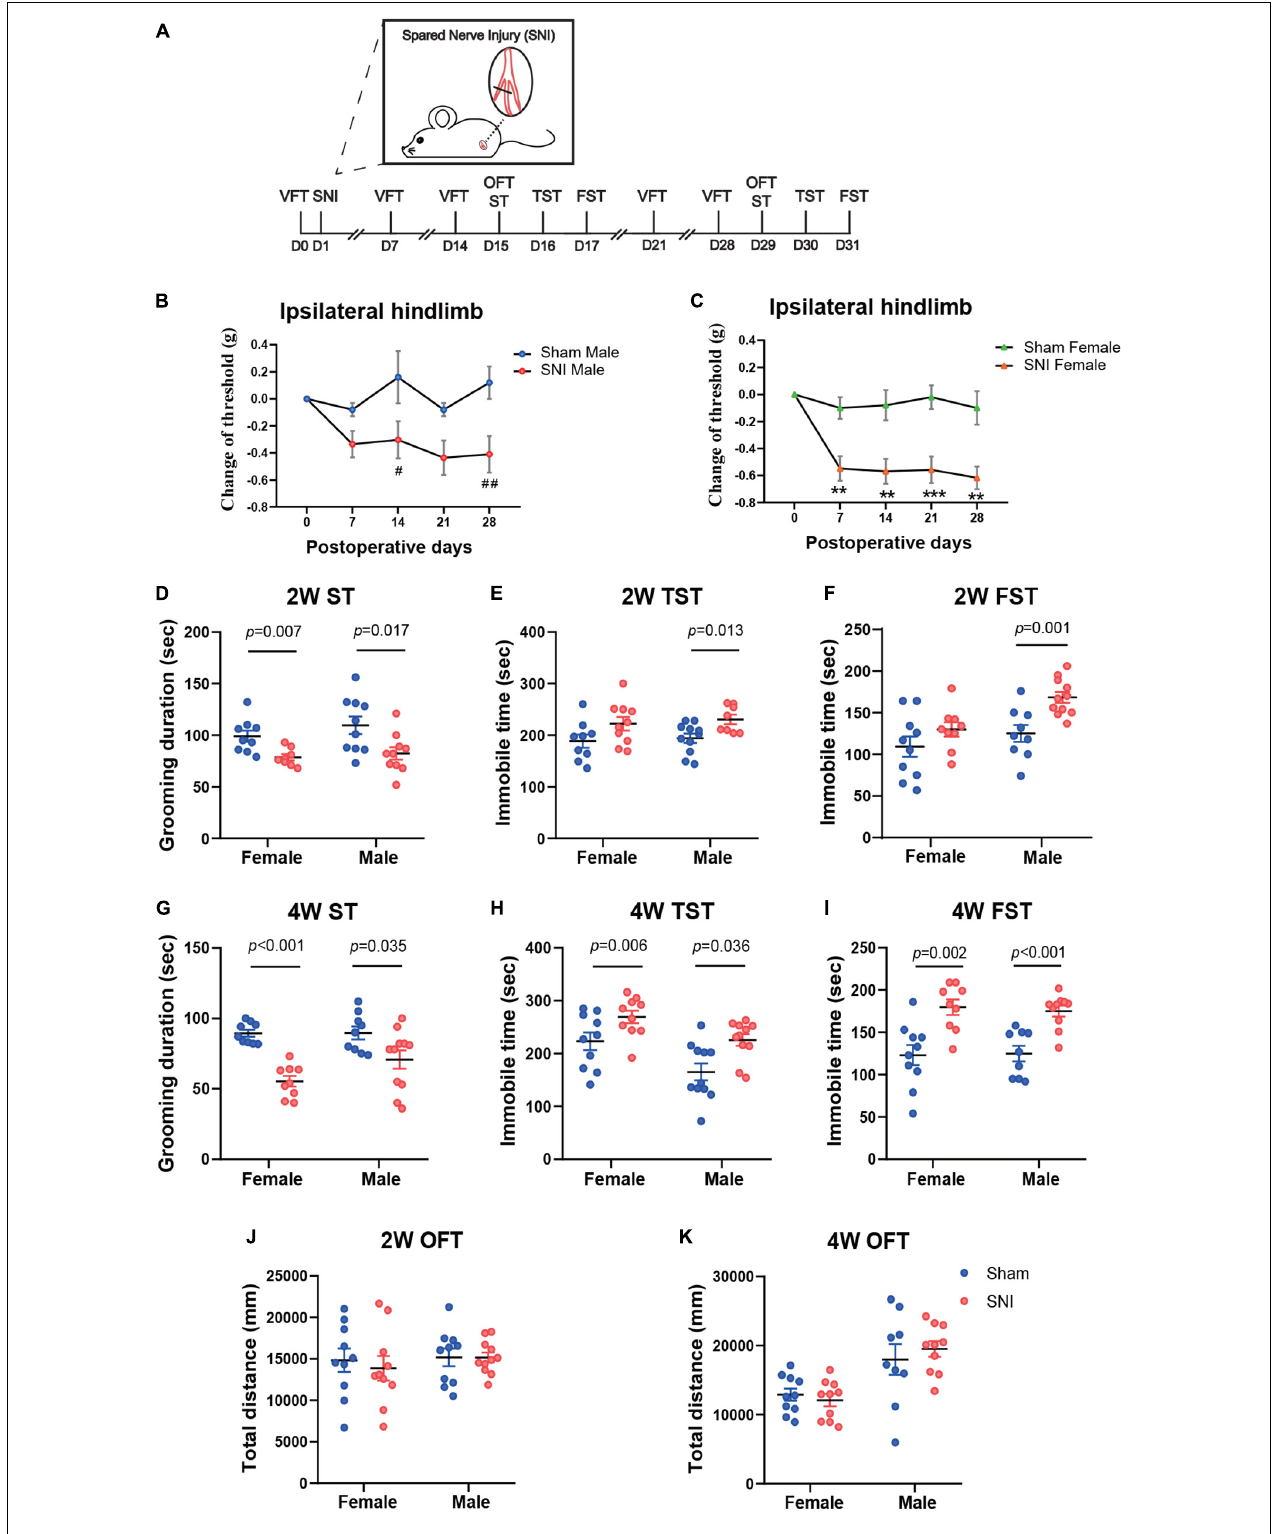
FIGURE 1 | The spared nerve injury (SNI) model of neuropathic pain induces mechanical allodynia and depression-like behaviors in both female and male mice at 2 and 4 weeks after surgery. (A) The schema for SNI and the experimental timeline showing the sequence of surgery and behavioral tests. (B,C) Changes in